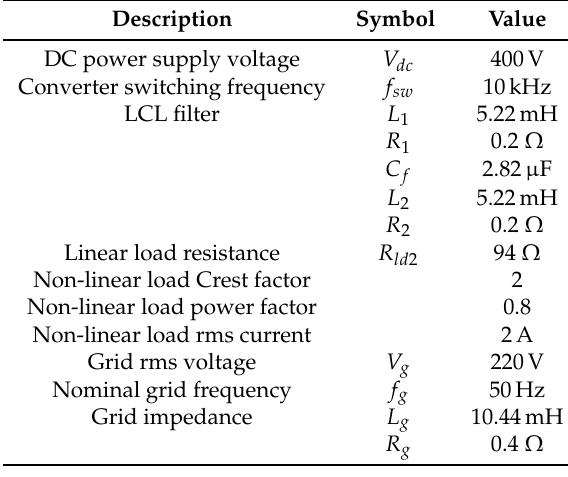
Table 1. Nominal parameters for the experimental setup, referring to the diagram shown in Figure 1.